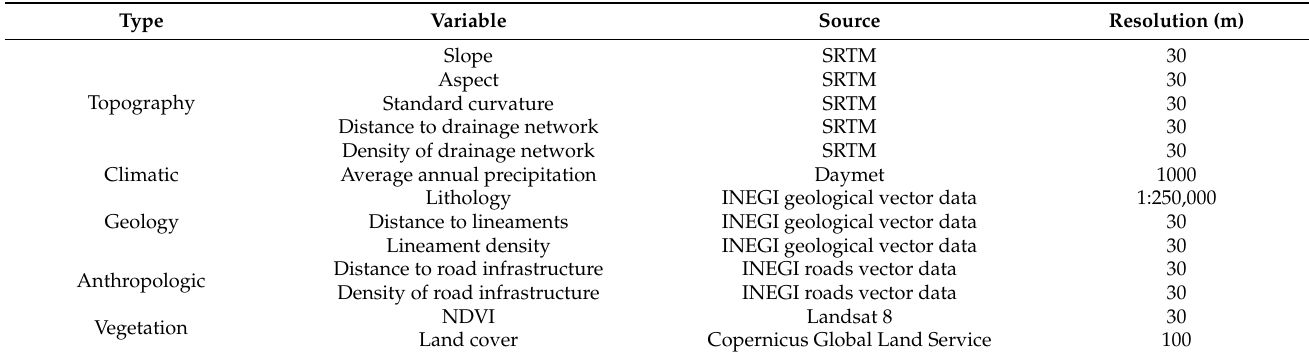
Table 1. Explanatory variables used in the